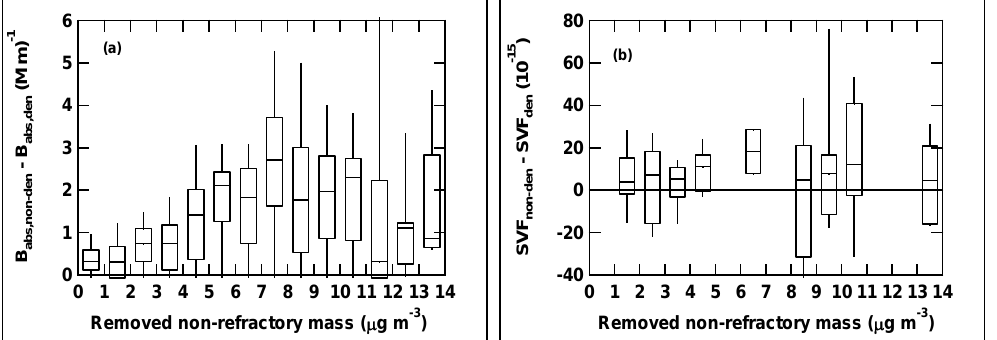
Figure 2: The difference in (a) particle light absorption coefficient and (b) soot volume fraction between the non-denuded and denuded condition as a function of non-refractory mass removed by the thermodenuder. Each individual box represents the 25th, 50th, and 75th percentiles of the measurement values while the 10th and 90th percentiles are represented by the bottom and top whiskers, respectively.